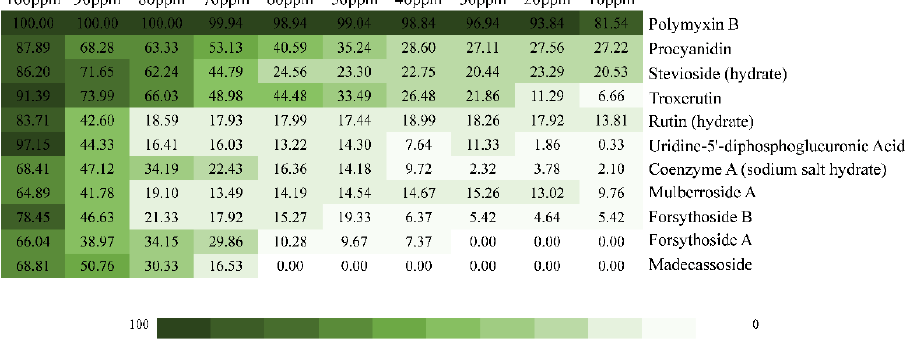
( D ): Rutin) interacting with V. parahaemolyticus LolB protein.